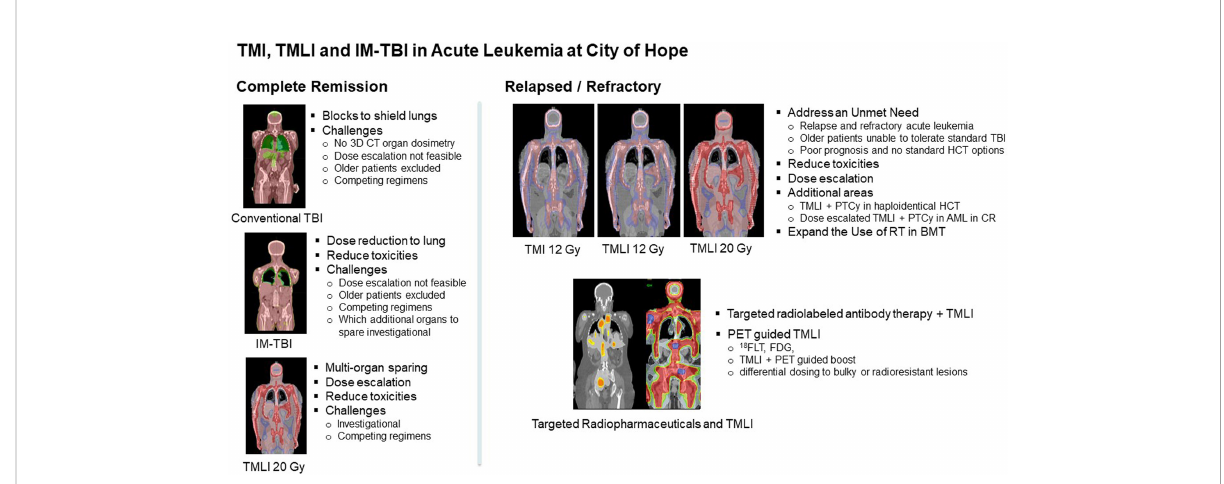
FIGURE 3 Overview of TMI, TMLI and IM-TBI clinical applications in patients with acute leukemia undergoing allogeneic hematopoietic cell transplantation at this